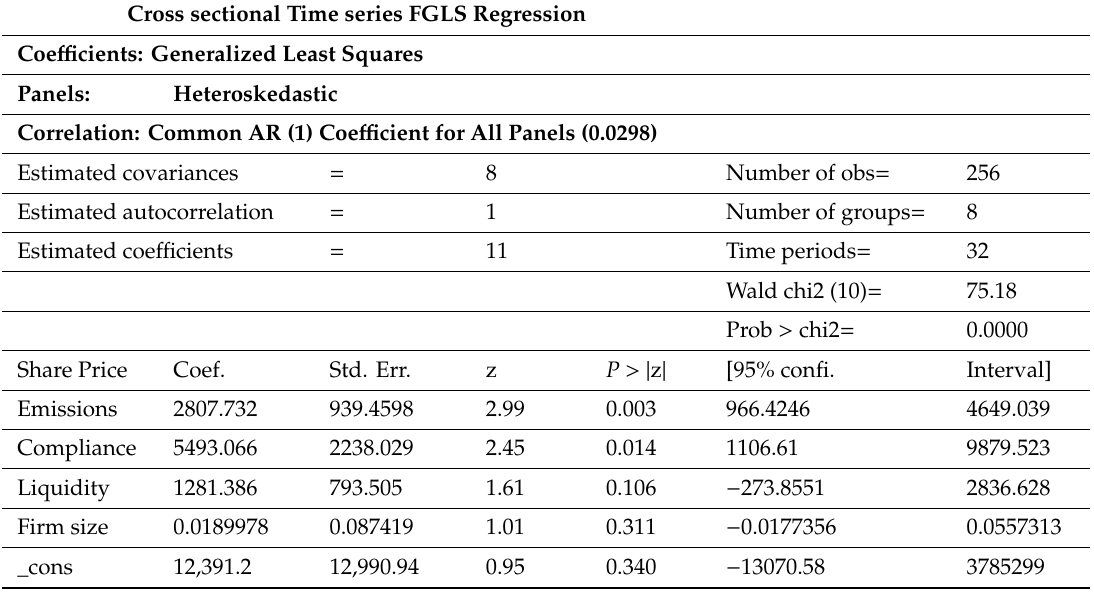
Table 6. Model 2 FGSL regression—share